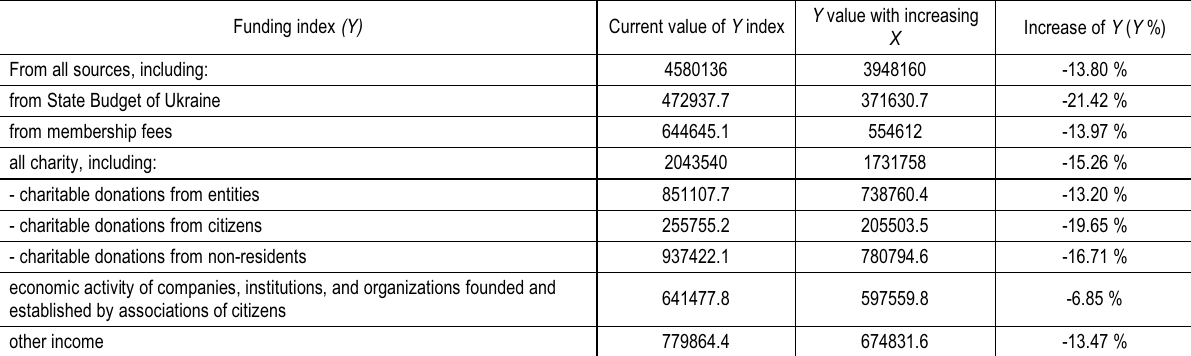
Table 13.The impact of “Number of companies, institutions, organizations founded and created by the associations of citizens” factor on sources of funding of NGOs Funding index